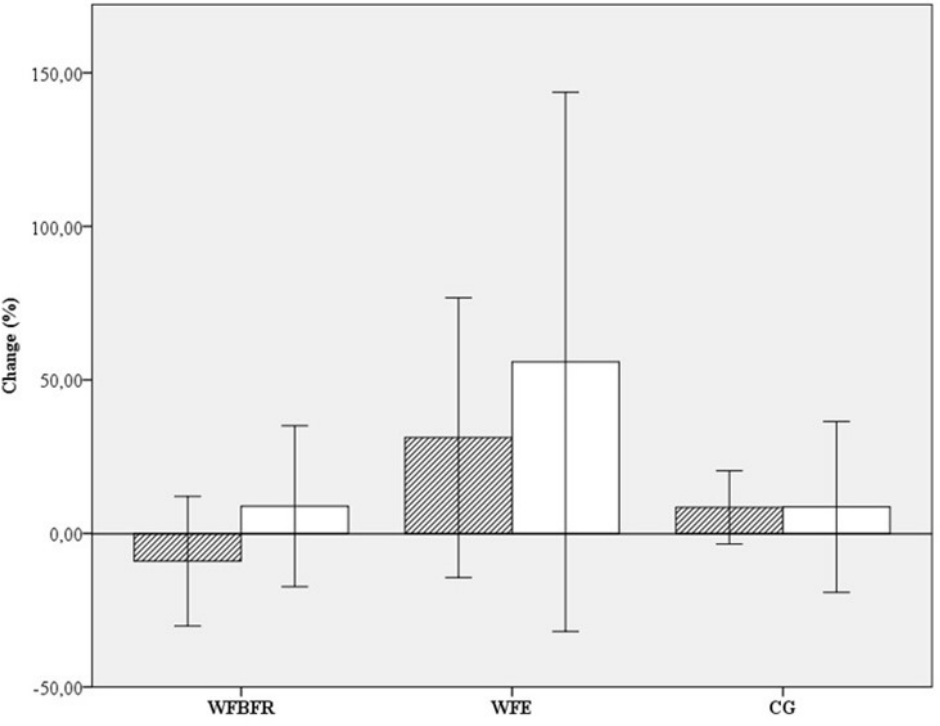
Figure 4. Effects of treatments on the variables: cortisol (CORT, hatched bars) and interleukin-6 (IL-6, open bars), expressed as percentage chang- es from pre- to post-test. Values are means ±